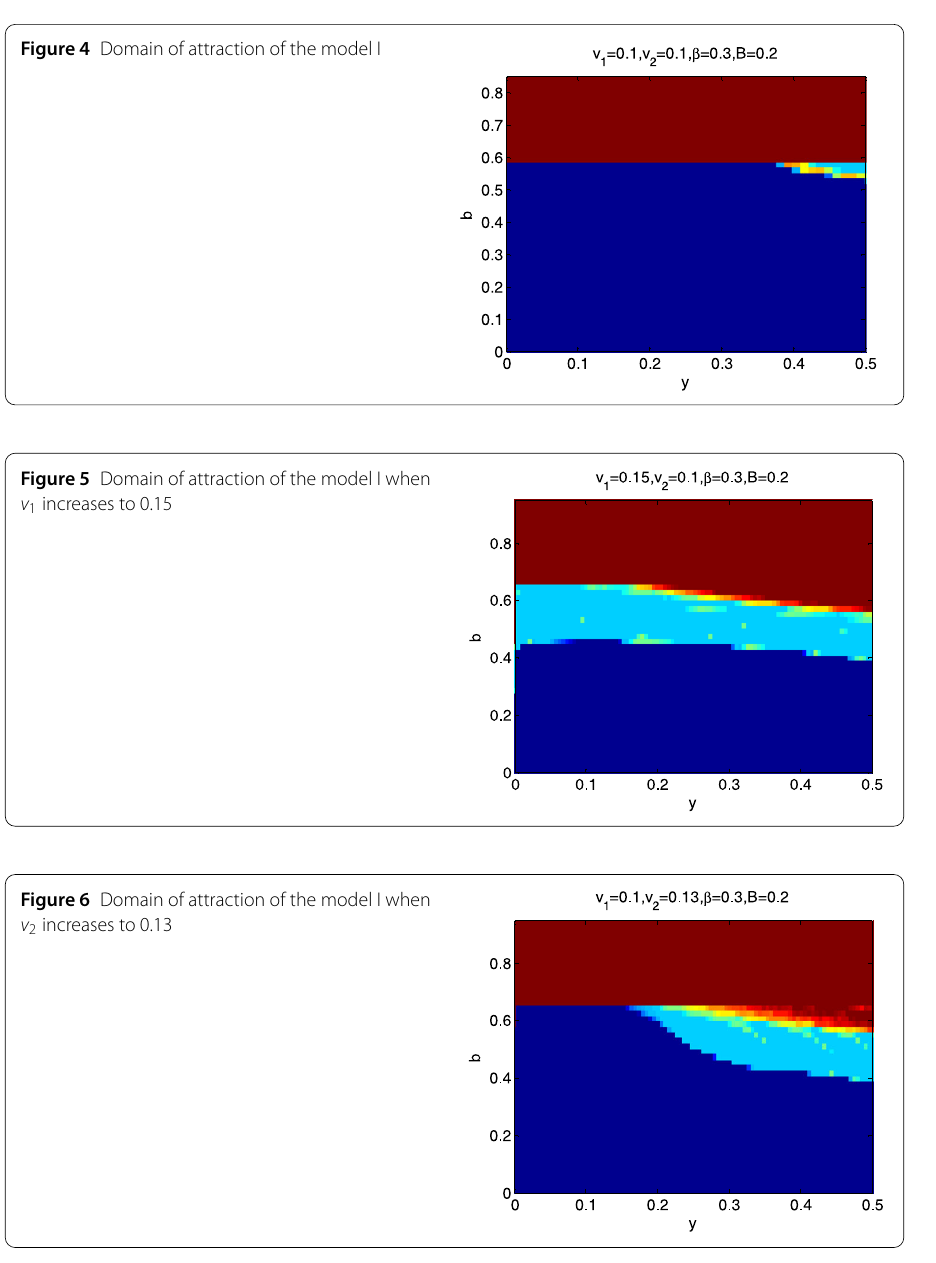
Figure 4 Domain of attraction of the model I